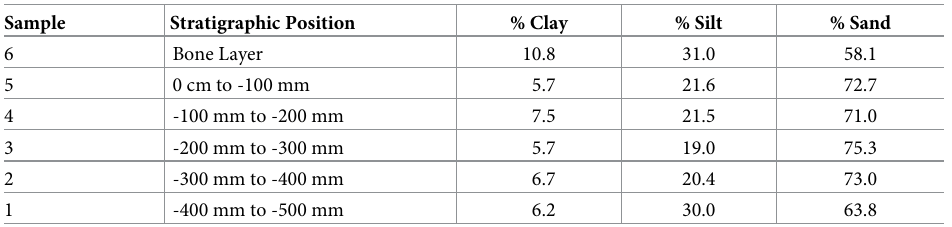
Table 2. Grain size distribution of rocks encasing NDGS 2000.